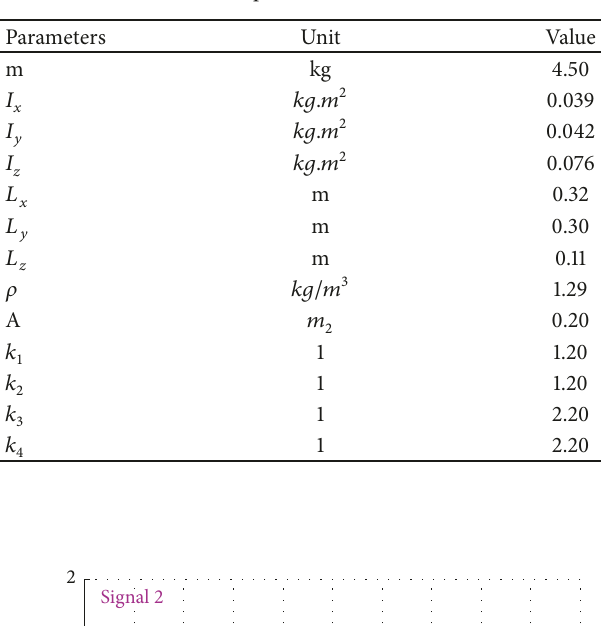
Table 1: Simulation parameters of the DTR vehicle.